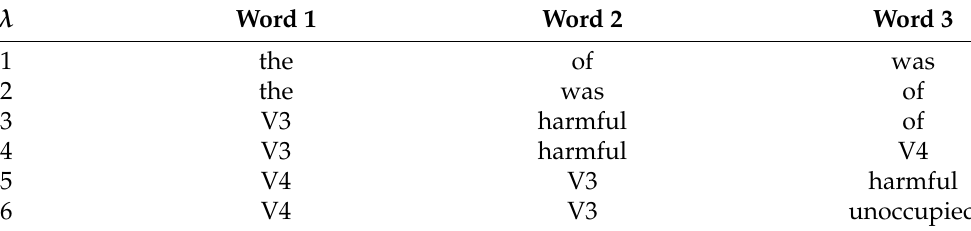
Table 6. The three most important words in the GLM regressor.